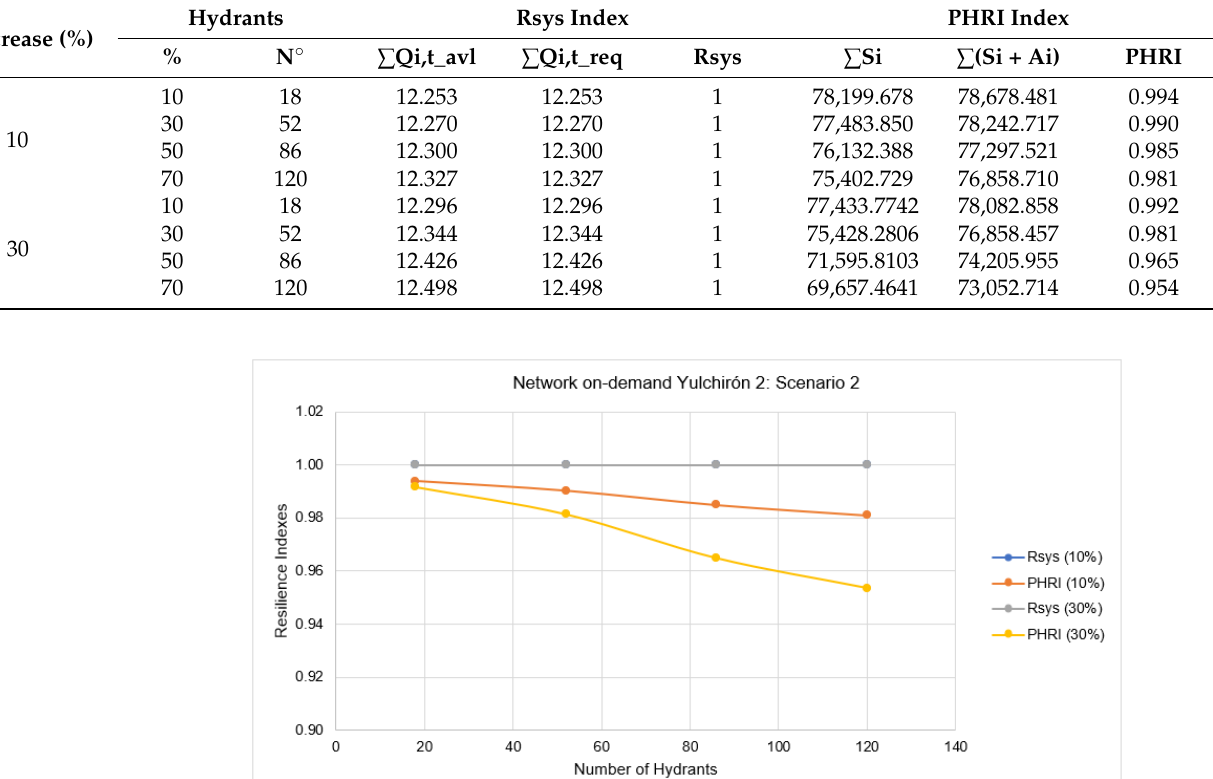
Table 5. “Rsys” and “PHRI” results, in scenario 2 on-demand.